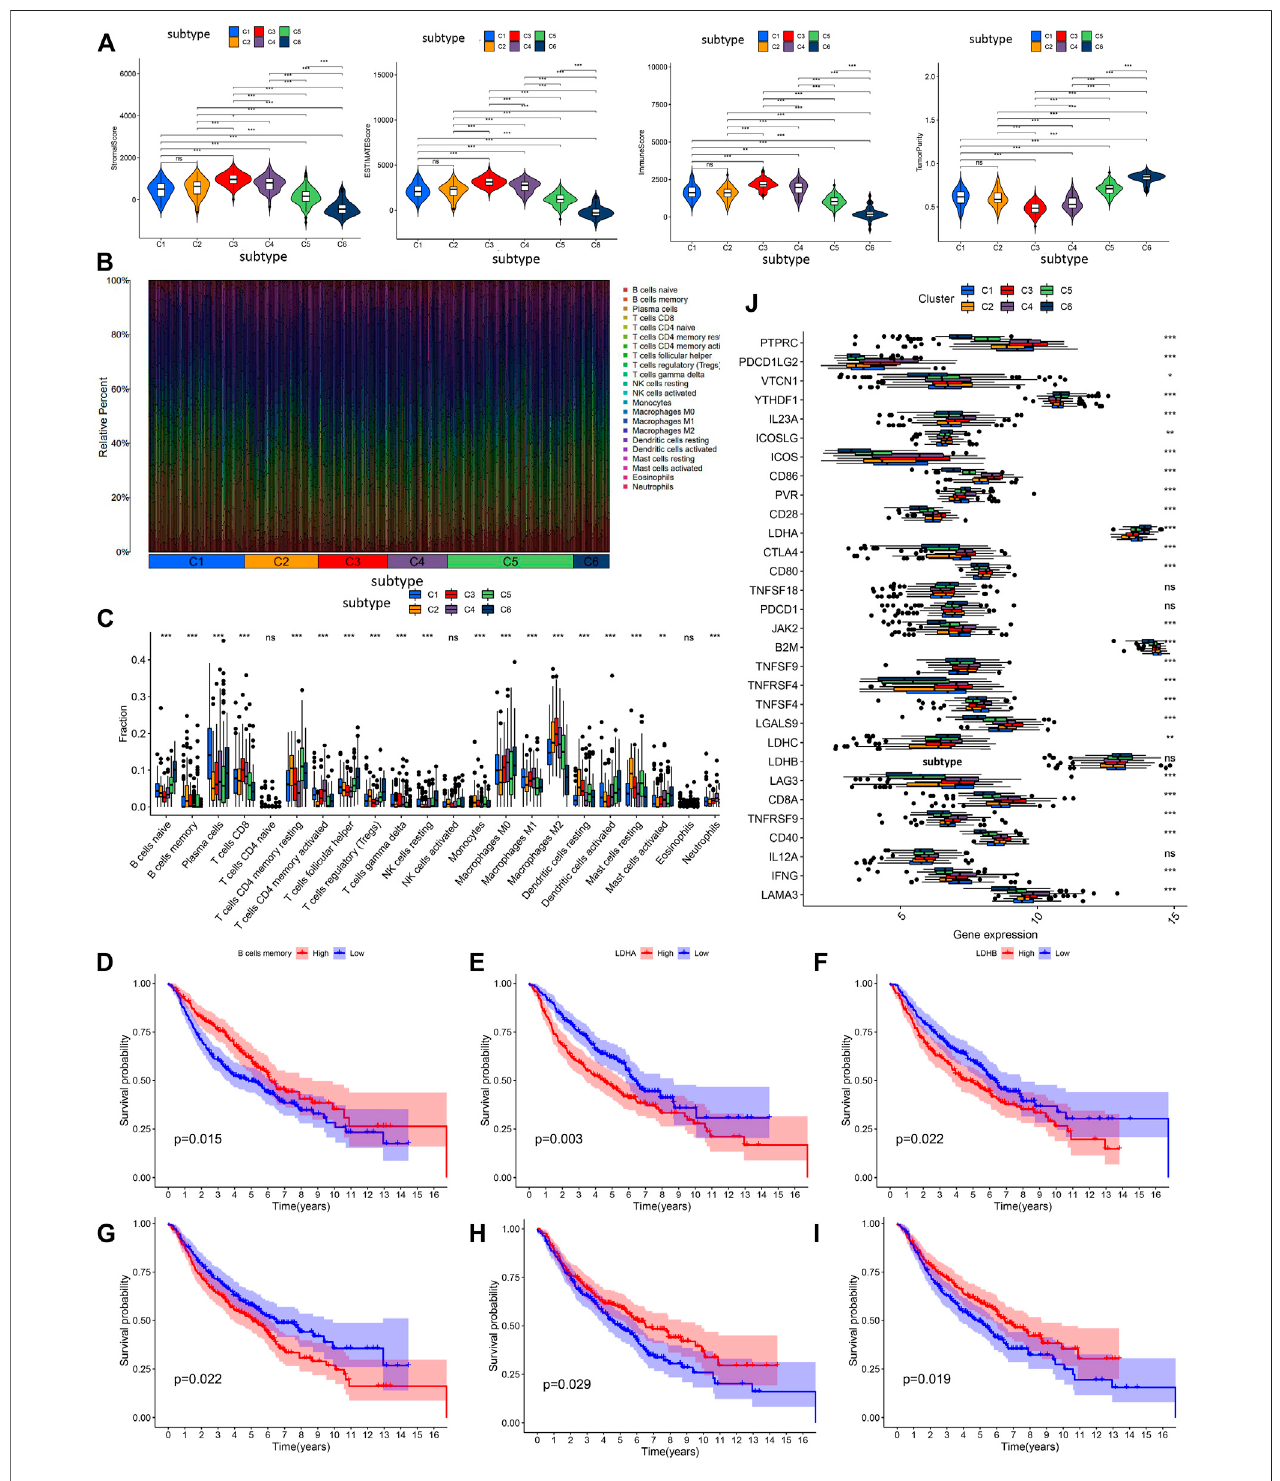
FIGURE 4 | The analysis of tumor microenvironment scores, and prognostic analysis in immune cell in fi ltration and immune checkpoint genes. (A) Difference analysis of immune cell score, stromal cell score, ESTIMATE score and tumor purity among the six subtypes. (B) The accumulation percentage map of 22 kinds of immune cells in six subtypes from different LUAD samples. (C) Box plots of in fi ltration density of 22 kinds of immune cells in different subtypes. Kaplan-Meier survival analysis of immune cells (D) and immune checkpoints (E – I) . (J) Differential expression analysis of 30 recognized immune checkpoints in different subtypes. ns p > 0.05, * p < 0.05, ** p < 0.01, *** p < 0.001.